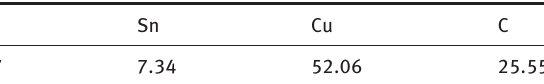
Table 2: Chemical composition of tin-enriched phase obtained by EDS spectra in atom% Fe